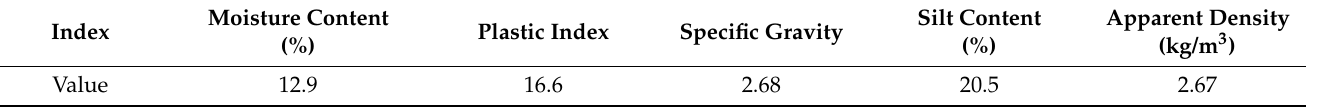
Table 1. Basic physical properties indexes of recycled aggregate